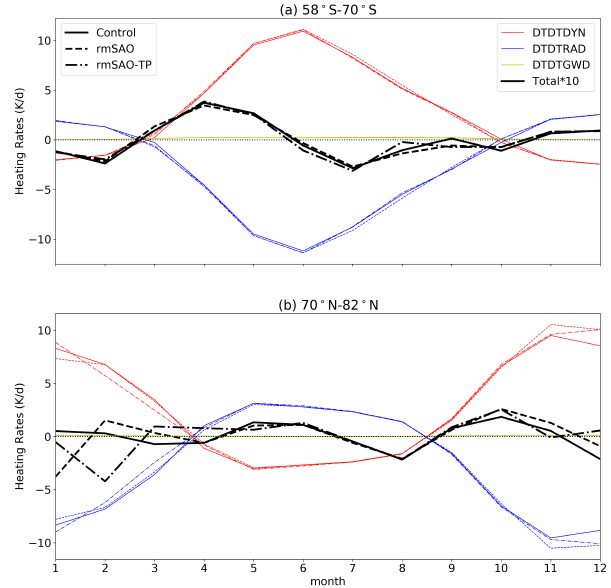
Figure 12. Annual cycle of the heating rates at 0.3 hPa on average around the SH high latitudes (58 ◦ S–70 ◦ S) ( a ) and the NH high latitudes (70 ◦ S–82 ◦ S) ( b ). The red, blue and yellow lines indicate the heating rates related to dynamics (DTDTDYN), radiation (DTDTRAD) and GWD processes (DTDTGWD), respectively. The total heating rates, which are the sum of the dynamical, radiative and GWD heating rates, are illustrated by black lines. The solid, dashed and dotted-dashed lines indicate data from the control, rmSAO and rmSAO-TP simulations,